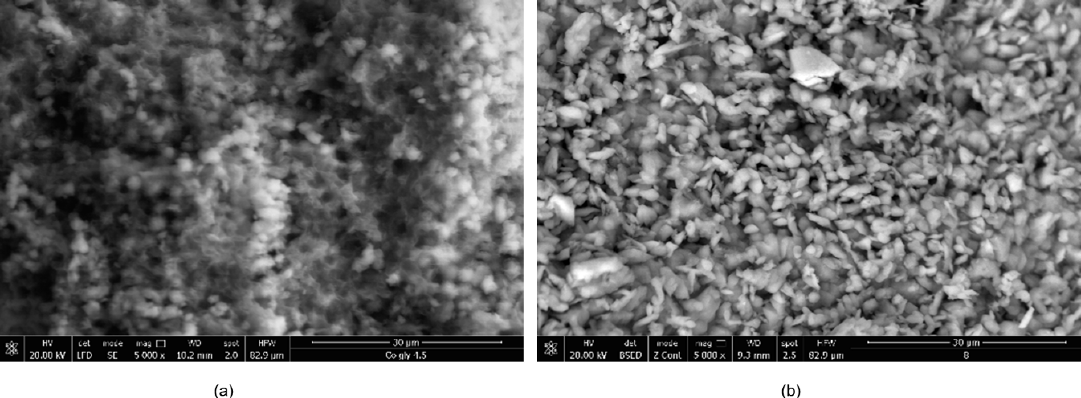
Figure 1. Scanning electron microscopy (SEM) images of the synthesized coordination networks (CNs) ( a ) Co–Gly; ( b ) Ni–Gly.